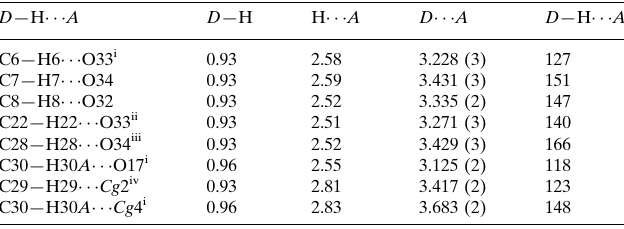
Hydrogen-bond geometry (A˚ , (cid:3) ).